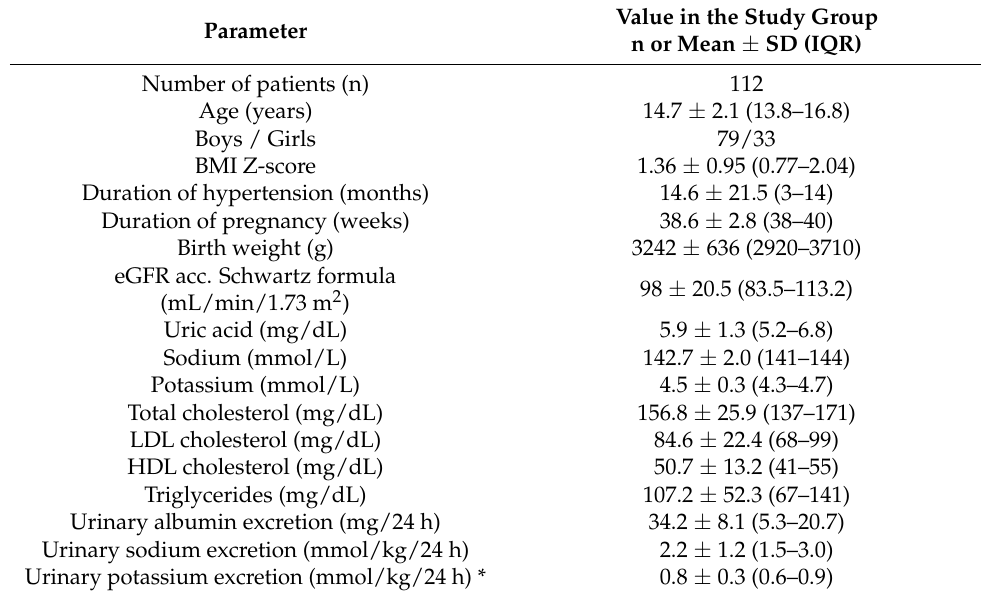
Table 2. Basic clinical and biochemical parameters in the study group.